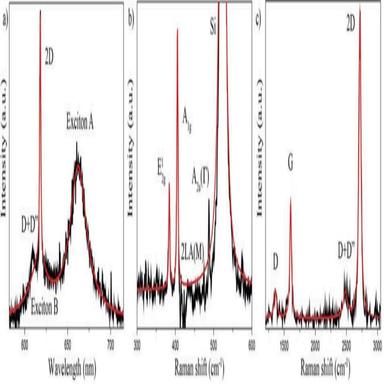
Room temperature PL and Raman characterization. The black line presents the measured spectrum while the red line is the Lorentzian cumulative fit. a) PL spectrum of MoS2 with 2D graphene Raman peak. Raman spectrum of b) MoS2 and c) graphene. (For interpretation of the references to colour in this figure legend, the reader is referred to the web version of this article.)